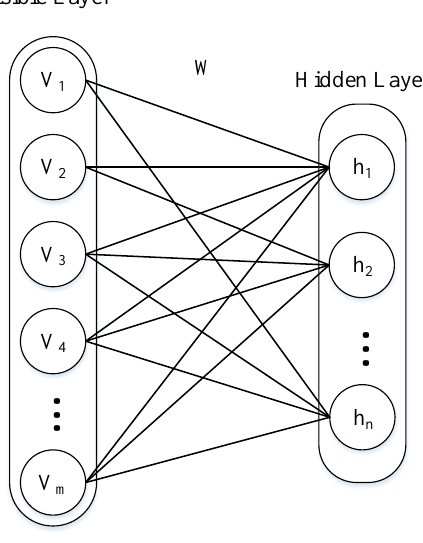
Figure 1. Schematic diagram of restricted Boltzmann machine.